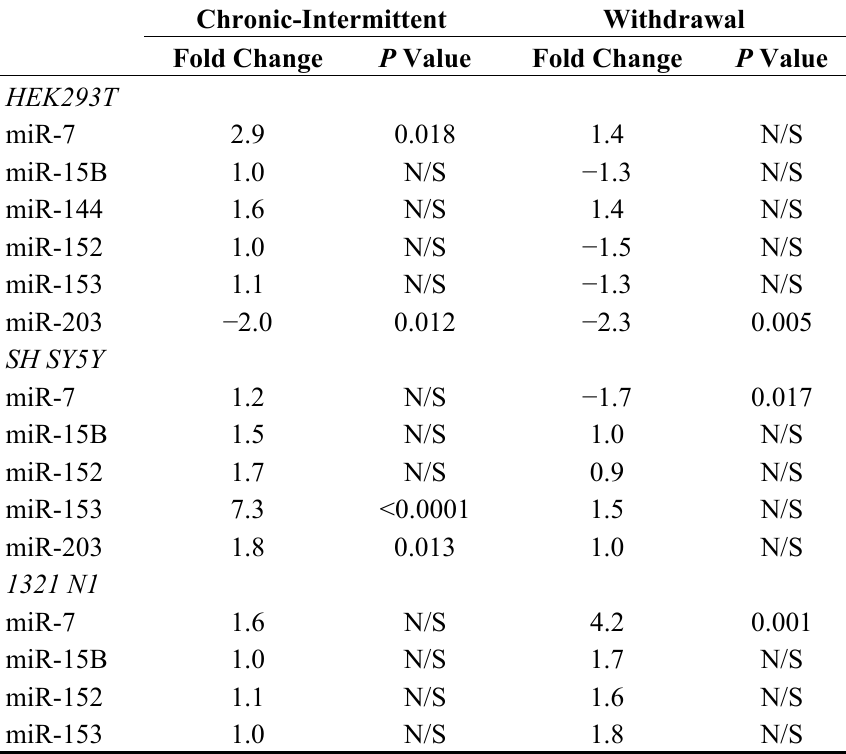
Table 2. Fold Change in expression of miRNAs following chronic-intermittent ethanol treatment and